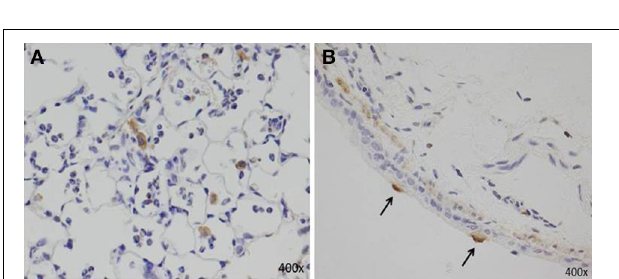
FIGURE 6 | Immunohistochemical staining with RANTES at 8h and 48h post-IT challenge. (A) AMs secreted RANTES as early as 8h after IT challenge; abundant recruited neutrophils in alveolar spaces did not produce RANTES. (B) Bronchial epithelial cells positive for RANTES at 48h